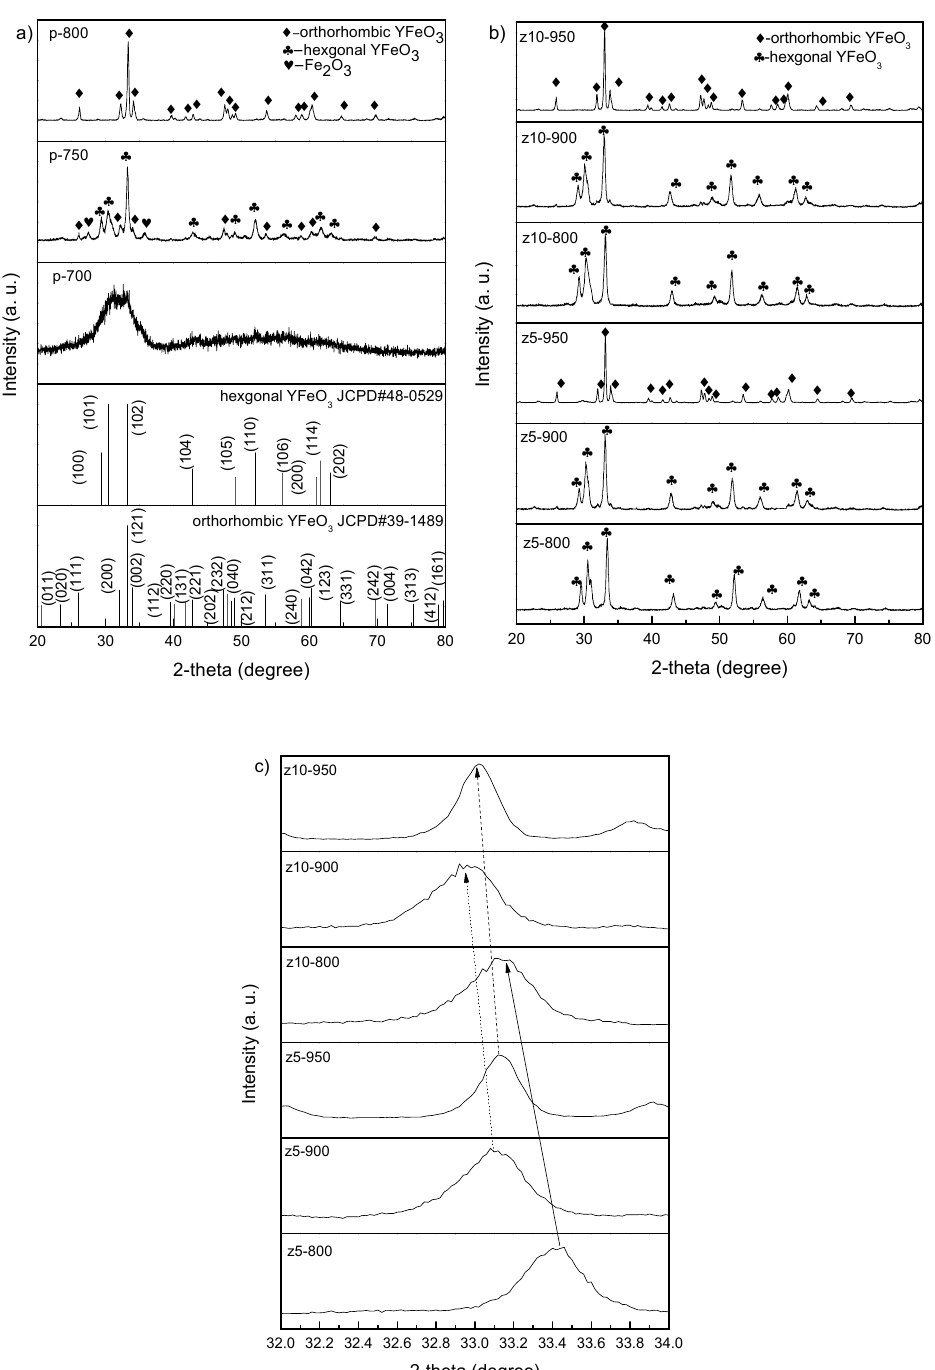
Figure 1. XRD patterns of ( a ) pure YFeO 3 ; ( b ) YFe 0.95 Zr 0.05 O 3 and YFe 0.90 Zr 0.10 O 3 synthesized at different calcination temperatures and ( c ) the magnified patterns at 2 θ ~ 33°. Compared with the orthorhombic YFeO 3 , the hexagonal YFeO 3 is metastable. The stability of the orthorhombic YFeO 3 phase can be evaluated by the tolerance factor ( t ) [16]: